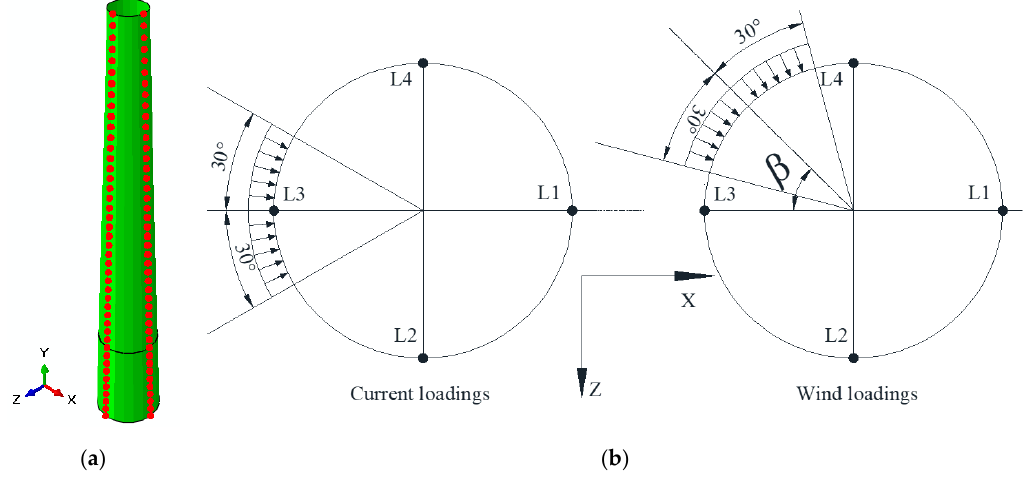
Figure 4. The four lines placement along the tower model regarding the direction angle β . ( a ) the finite element model with lines 1, 2, 3 and 4; ( b ) the angle β between wind and current.